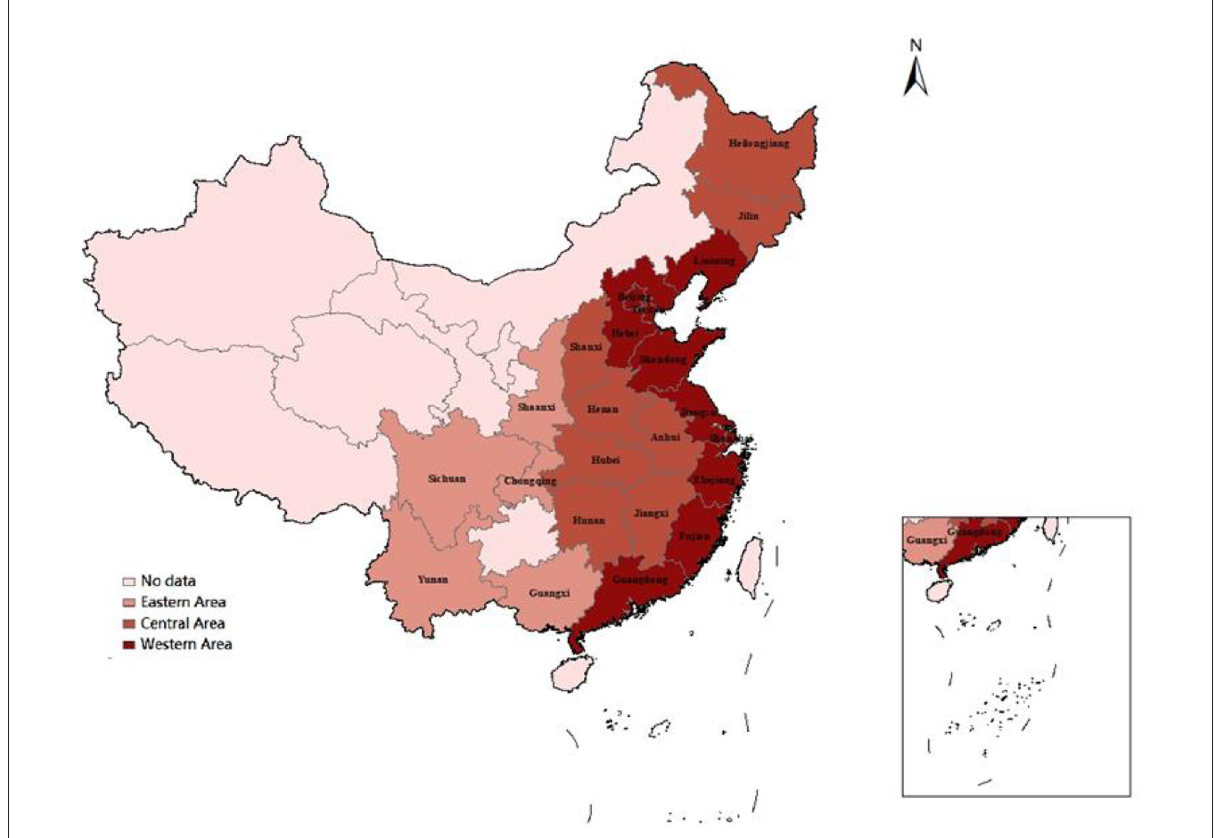
FIGURE2 Division of eastern, central and western